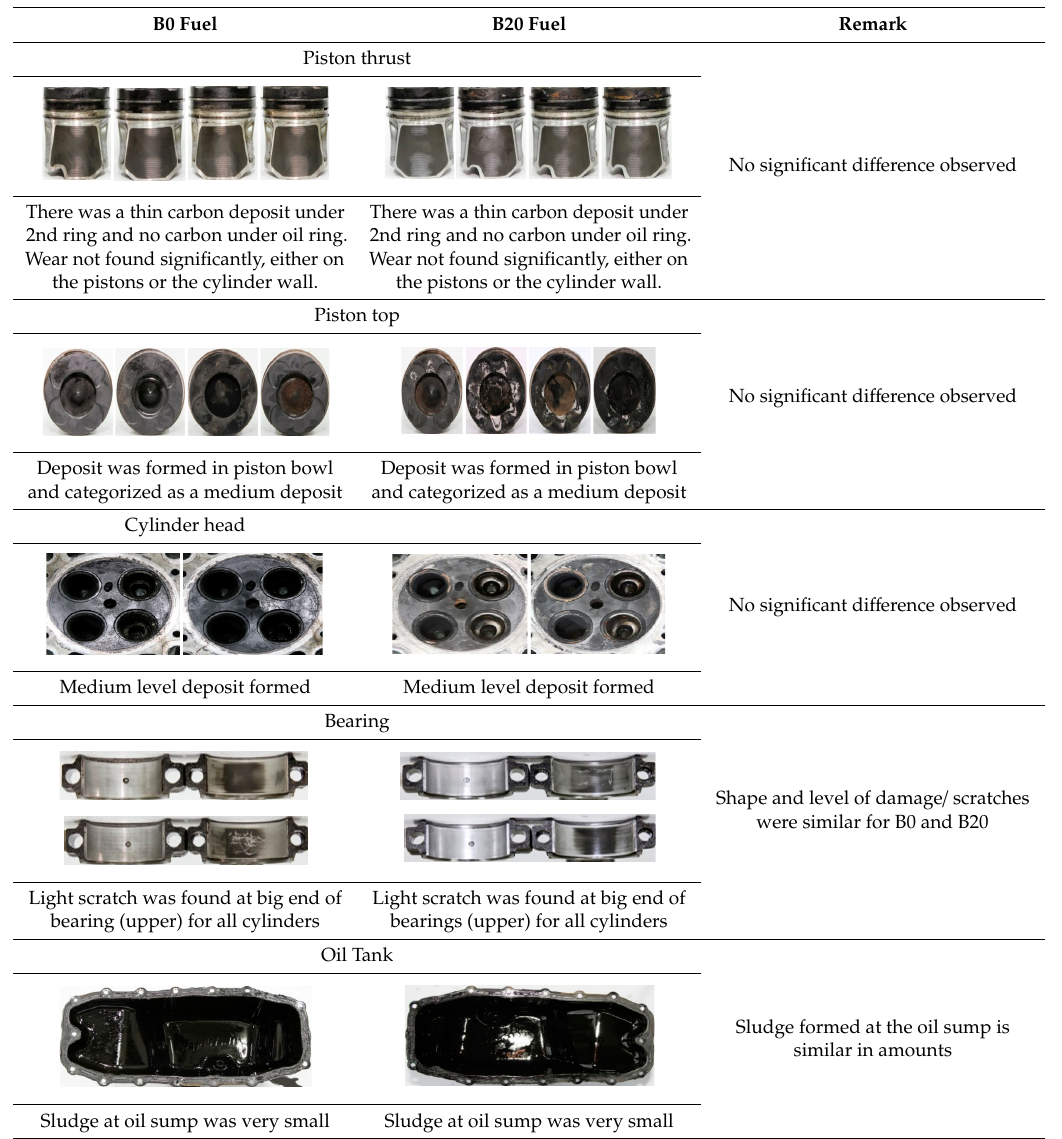
Table 3. Comparison of engine components for B0 and